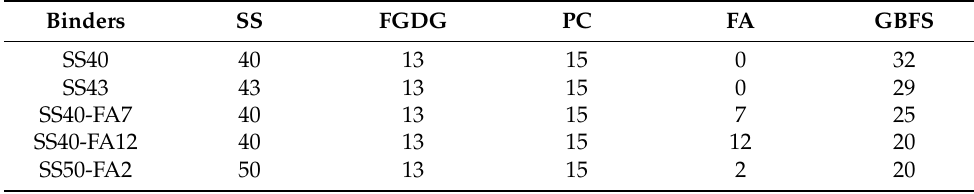
Table 2. Mixture proportions (wt. %) of SS-based composite cementitious